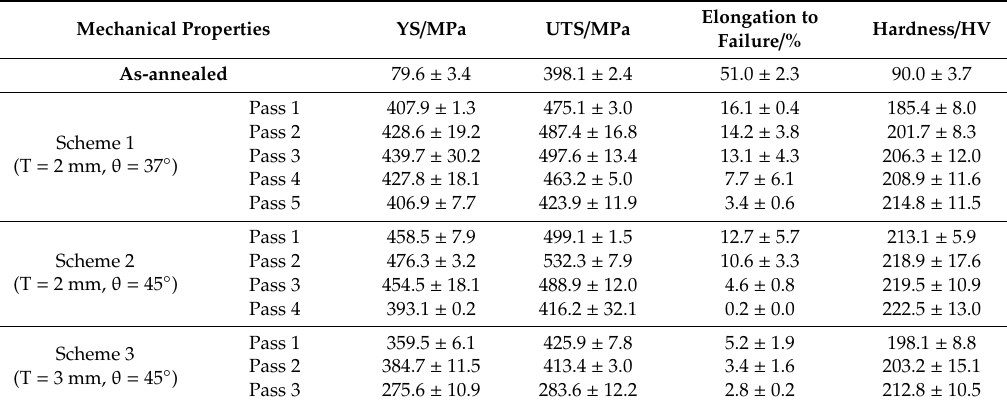
Table 1. Mechanical properties of nickel sheets before and after CGP [18].